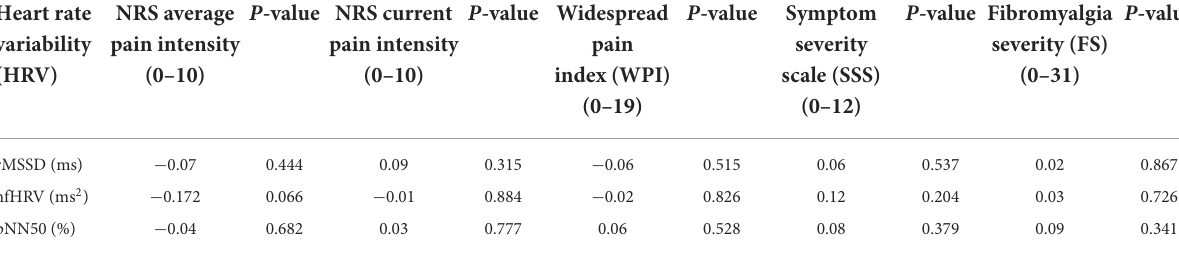
TABLE 2 Pairwise correlations of change from clinical visitation I to clinical visitation II between HRV, FM pain variables, and psychological distress ( N = 116). Heart